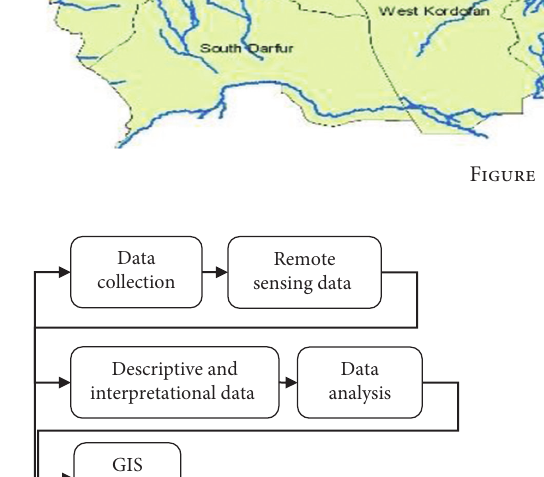
Figure 4: Generalized model of the proposed multilayer GIS database.